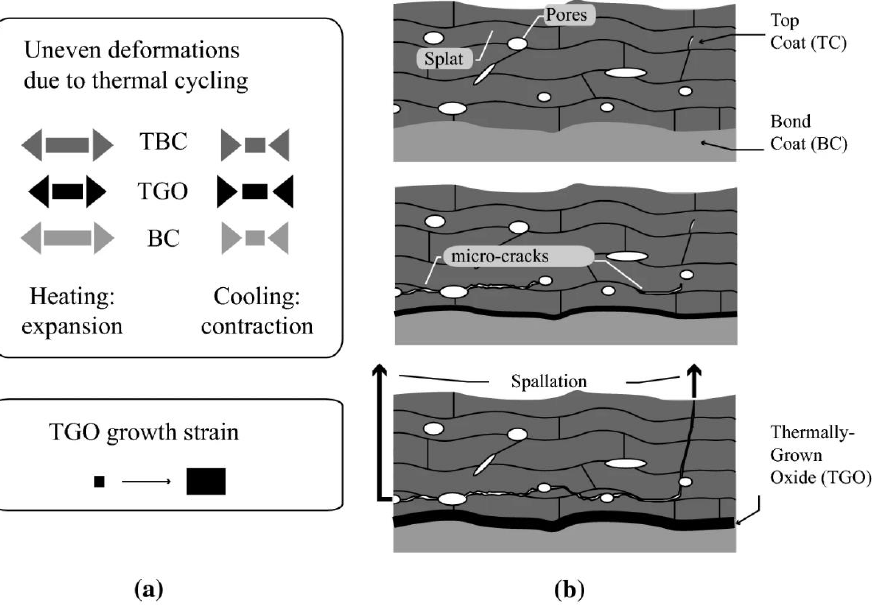
Figure 4. A failure mode illustration of APS deposition technology. Reprinted with permission from [18]. Copyright 2019 Springer Nature. ( a ) TBC loading conditions; ( b ) Crack coalescence and TBC failure.